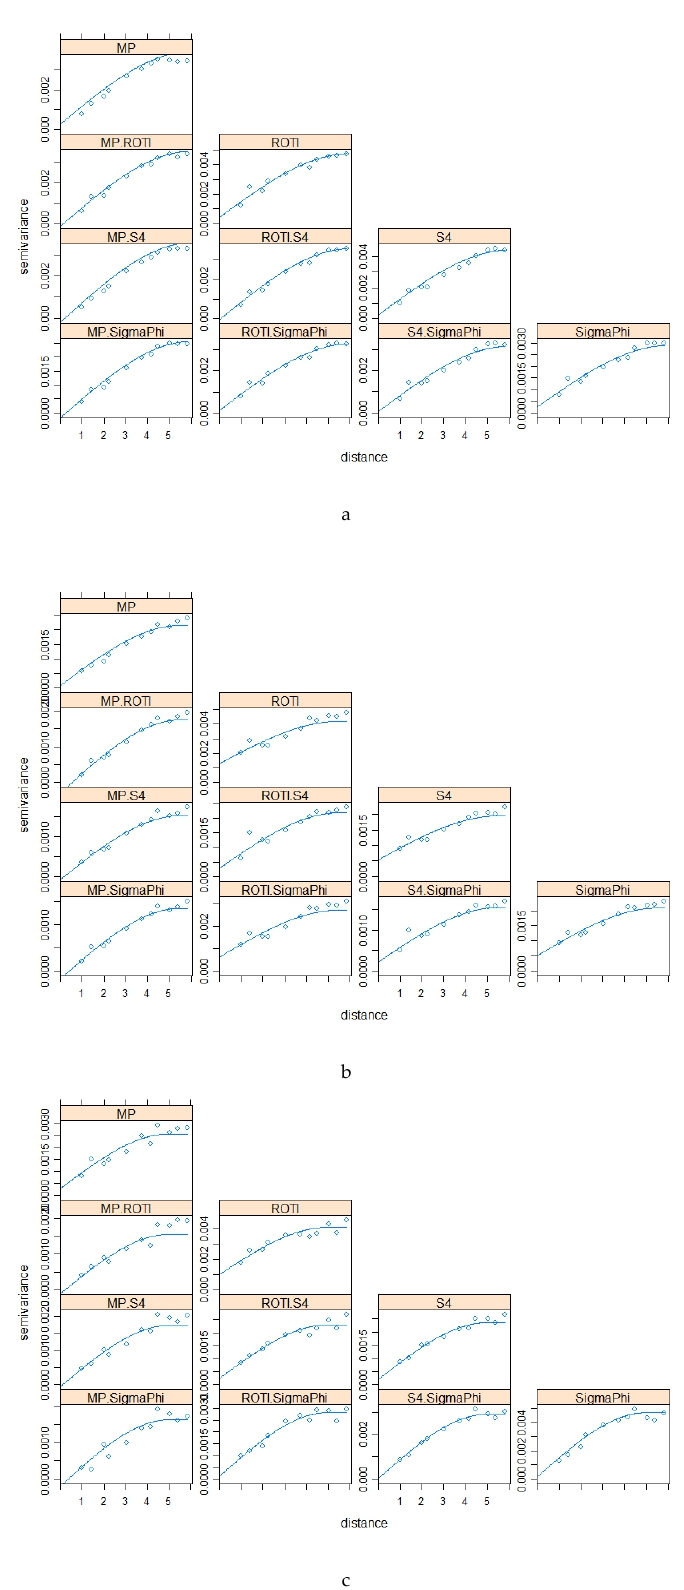
Figure 6. xxxxxxxxxxxxxx Figure 6. Variograms and cross-variograms for the four parameters. Figure 6a–c is for the data illustrated in Figure